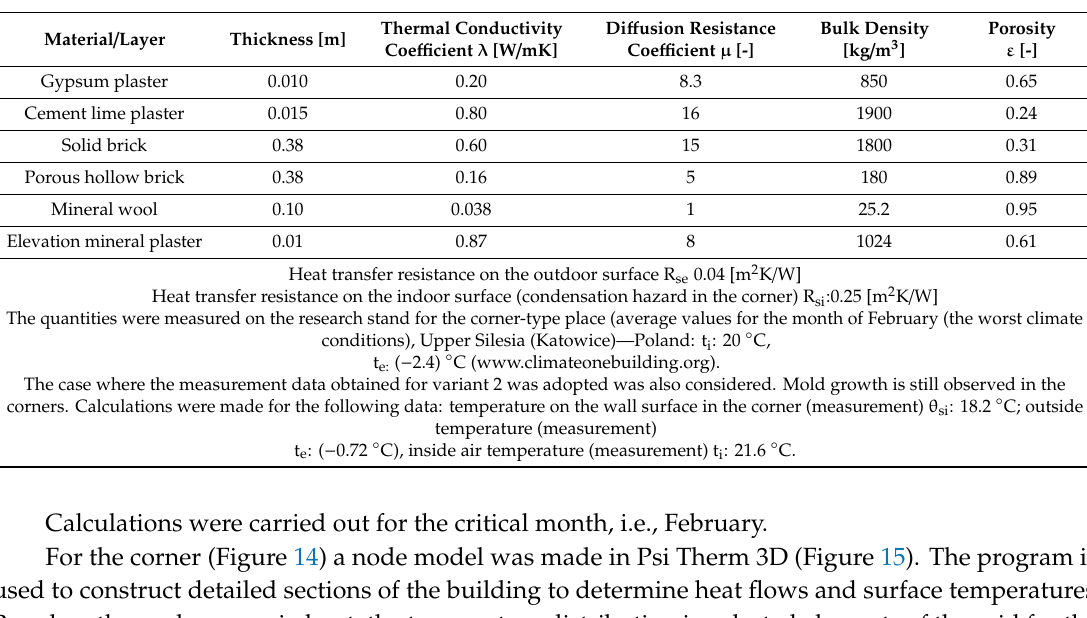
Table 2. Material data accepted for analysis.